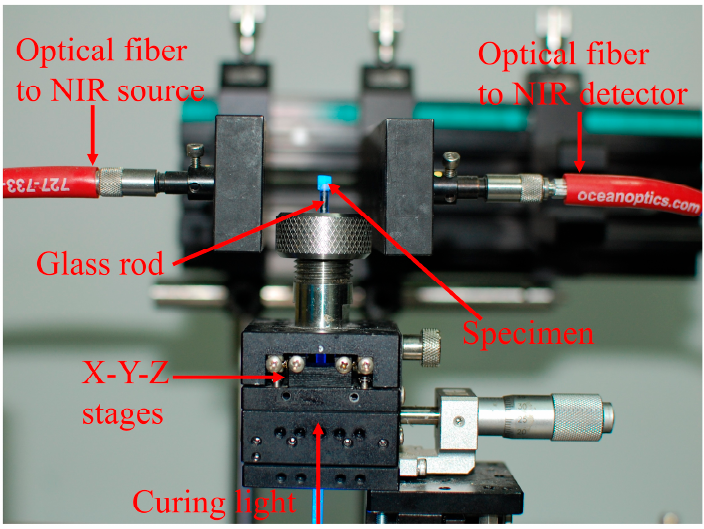
Figure 2. Photography of the in situ NIR spectroscopy for polymerization kinetics